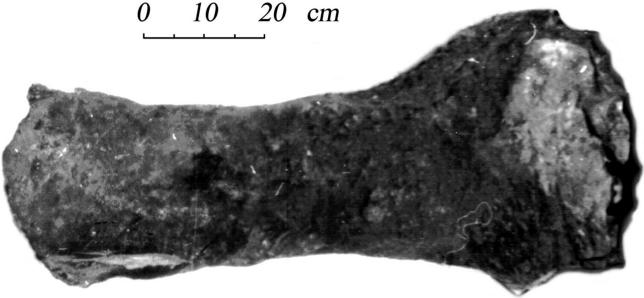
The Right Back Leg of the Woolly Mammoth(M. primigenius) Found in SiberiaThe well-preserved mammoth body fragment with foot (33 × 36 cm), shin, and ankle-joint (the total length is ~88 cm) was found in the Enmynveem River valley (north-eastern Siberia, Chukotka). The tissue material (bones, muscles, and skin) had no visible marks of tissue damage by insects or other animals. Radiocarbon dating of the skin and muscle tissue determined that the mammoth lived 32,850 ± 900 y ago [12].